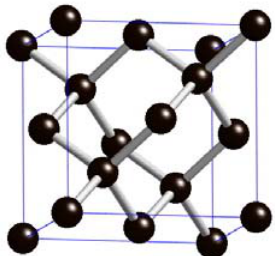
Figure 1. Schematic diagram of the lattice structure of diamond, showing the tetrahedral orientation of each C